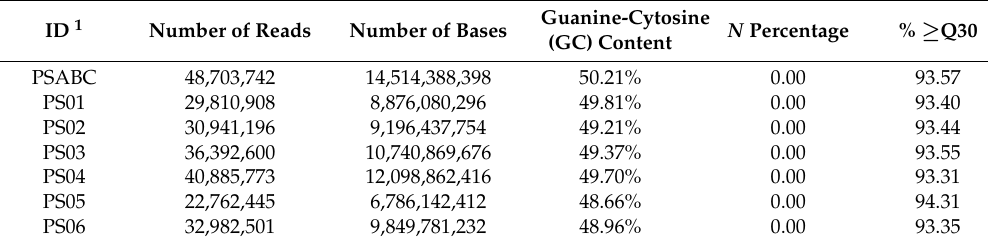
Table 1. Output statistics from sequencing of Polygonatum sibiricum transcriptome.